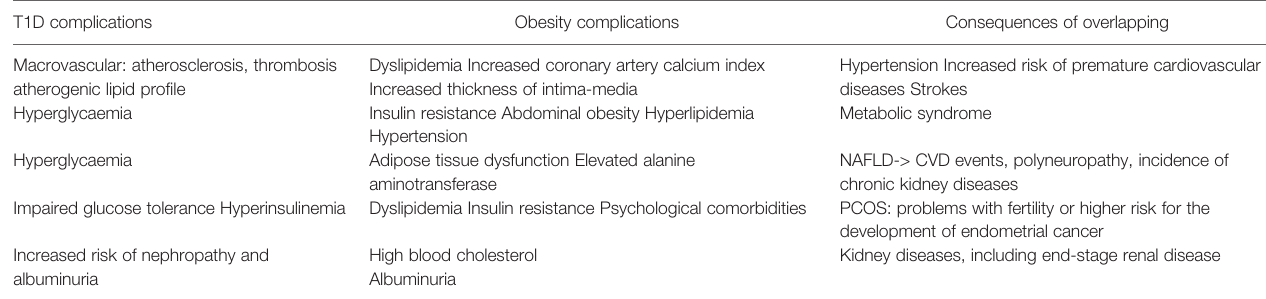
TABLE 3 | Consequences of overlapping T1D and obesity